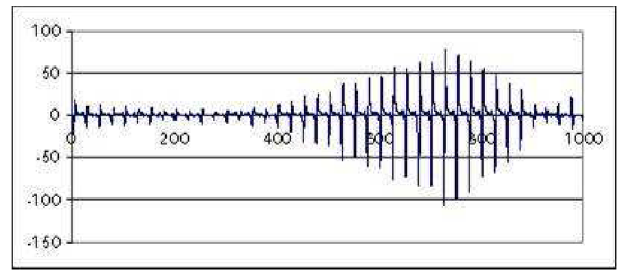
FIG. 21. (Color) Snapshot of horizontal position of the first 48 bunches in the SPS when the instability is present [6].